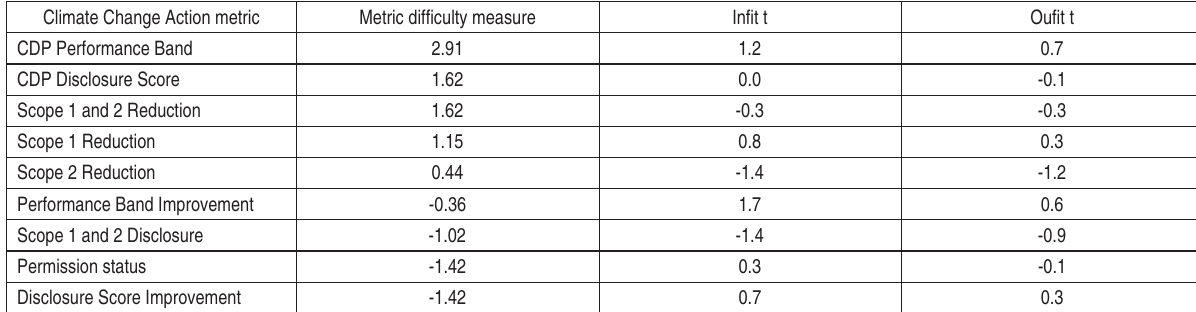
Table 2. “CDP” and capitalization should be consistent Difficulty Hierarchy of Climate Change